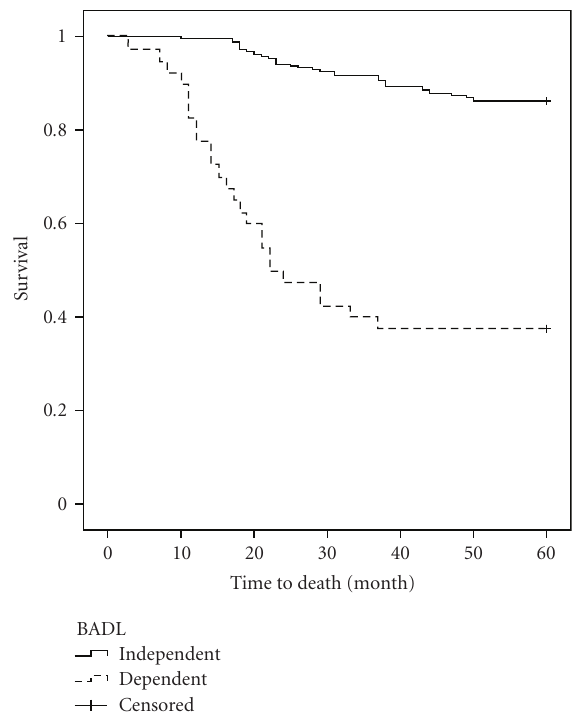
Figure 1: The Kaplan-Meier curve for ABDL according to the two groups, during the follow-up period.